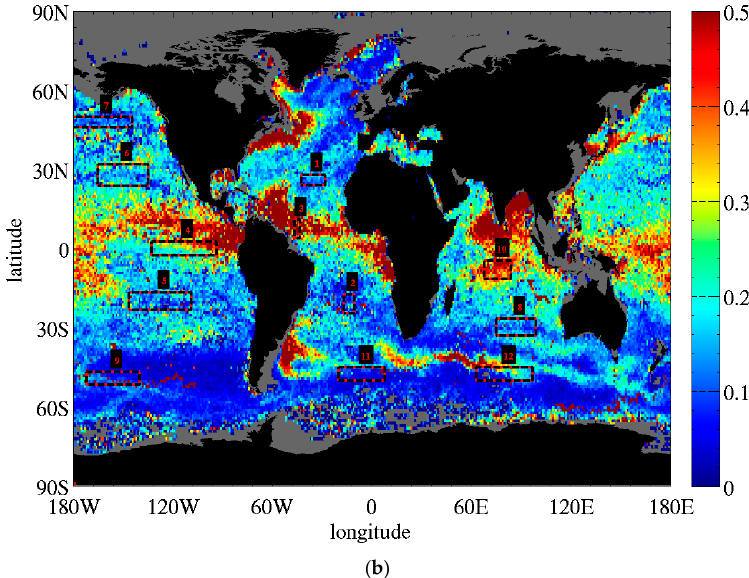
Figure 2. Map of long ‐ term SSS patterns and variability derived from in situ Argo measurements. ( a ) Map of the average Argo SSS in 1° × 1° grid cells in latitude and longitude over the period Jan 2011–June 2018. ( b ) Standard deviation over time of monthly 1° × 1° average Argo SSS maps. The numbered red and black boxes report the limits for the regions of interest used to assess temporal variability of SSS (see text).